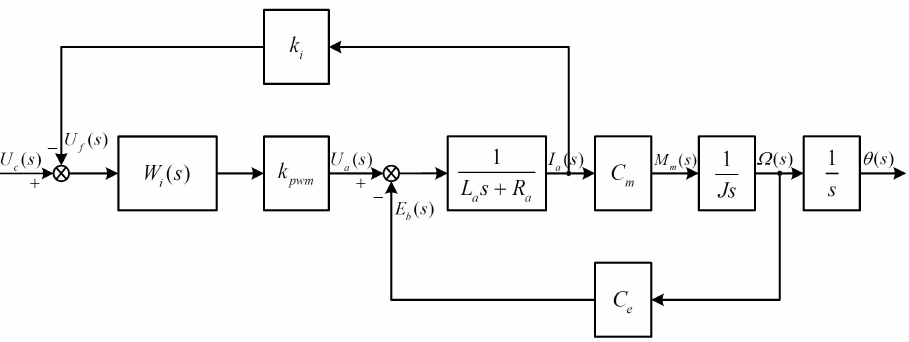
Figure 3. Gimbal electromechanical